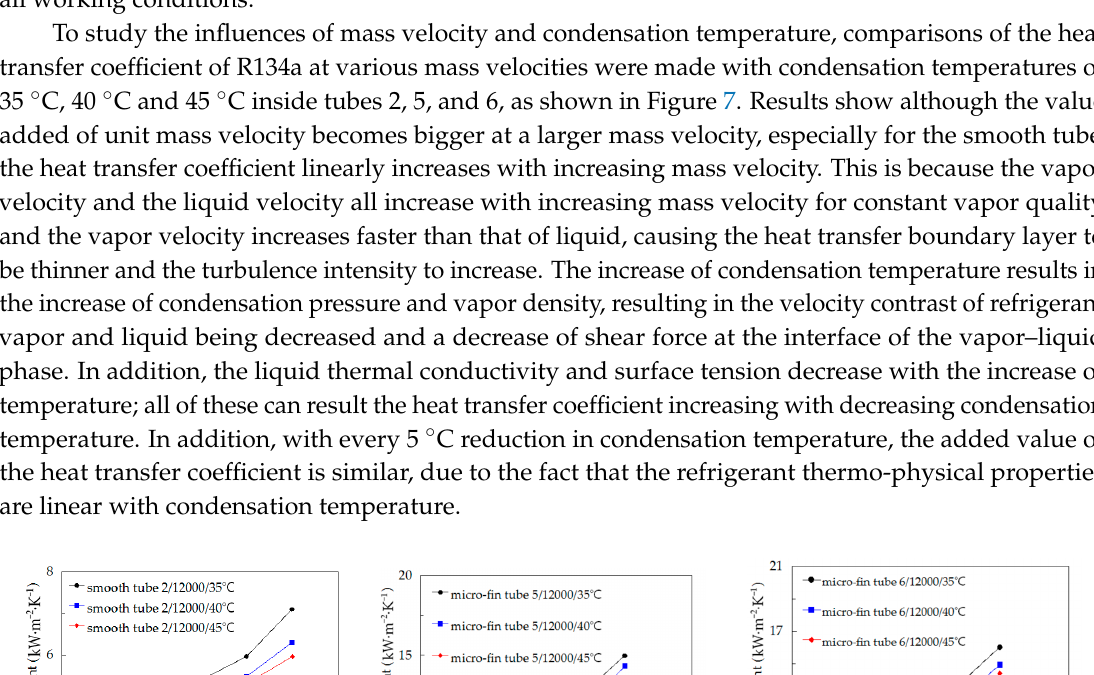
Figure 8. Influence of water-testing Reynolds number on the heat transfer coefficient inside ( a ) tubes 2; ( b ) 5 and ( c ) 6 for R134a.